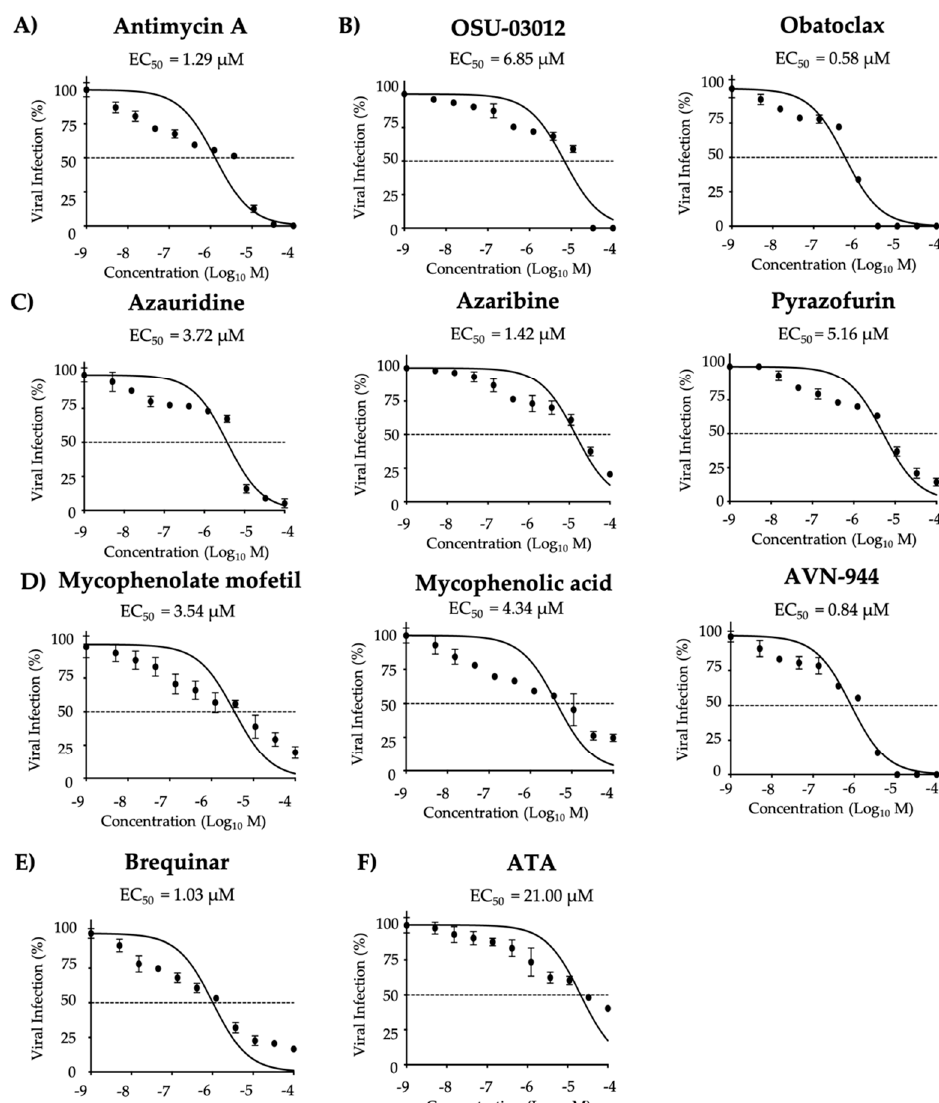
Figure 3. Inhibition of ZIKV Paraiba / 2015 replication during post-treatment: Vero cells (96-well plate format, 5 × 10 4 cells / well, quadruplicates) were infected with 25 PFU / well of Zika virus Paraiba / 2015. After 2 h of viral absorption, media containing virus was replaced by infection media (DMEM 2% FBS) containing the indicated doses of the inhibitors (3-folds dilutions, starting concentration 100 µ M) ( A ) Antimycin A, ( B ) OSU-03012 and Obatoclax, ( C ) Azaribine, Azauridine, and Pyrazofurin, ( D ) Mycophenolate mofetil, Mycophenolic acid, and AVN-944, ( E ) Brequinar, and ( F ) Aurintricarboxylic acid (ATA); and 1% Avicel. At 36 h post-treatment, the cells were fixed and immunoassayed using the anti-E 4G2 mAb. Plaques were counted with an automated ELISPOT reader. Dotted line indicates 50% inhibition. Data were expressed as mean and SD from three independent experiments conducted in